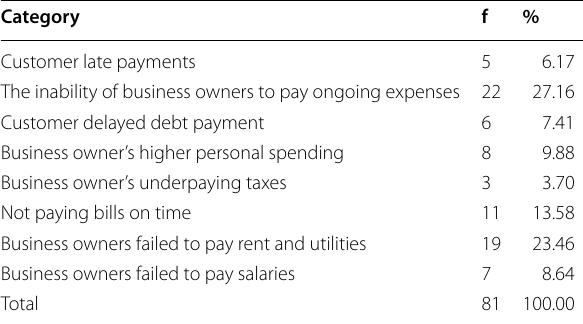
Table 8 Determinants of the problems encountered by the respondents that lead to business failure in terms of the financial